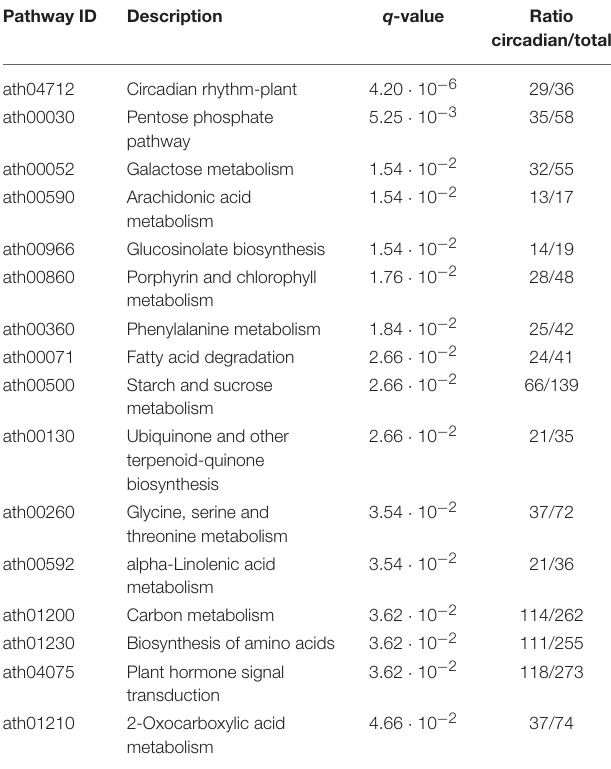
TABLE 2 | Significantly enriched pathways among the Arabidopsis circadian